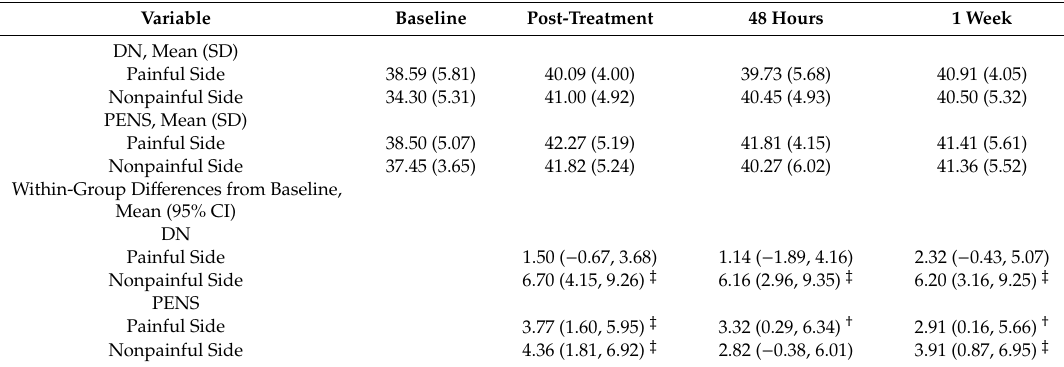
Table 6. Cervical side-bending range of movement di ff erences within- and between-group. Variable